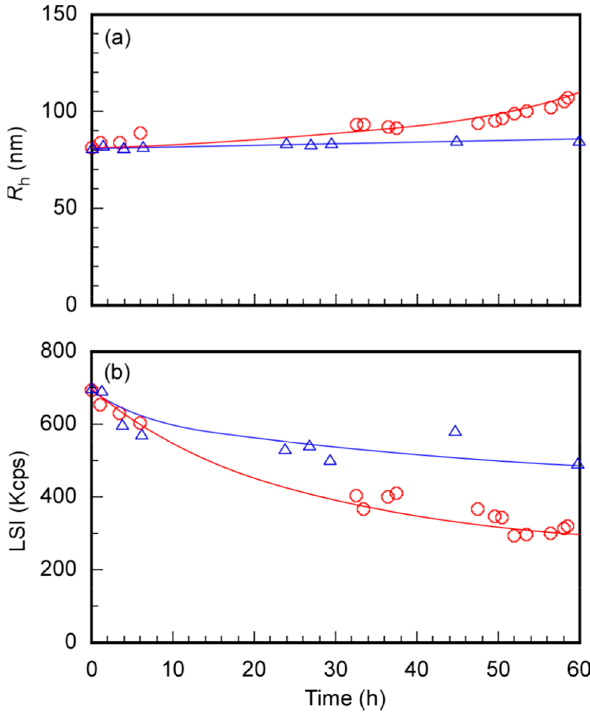
Figure 7. Time dependence on ( a ) hydrodynamic radius ( R h ) and ( b ) light-scattering intensity (LSI) for PEG 54 -P(AA/VE6/ γ TCP29) 140 at C p = 0.10 g/L at 25 °C in acetate buffer of pH 5.2 ( ○ ) and in PBS of pH 7.4 ( △ ).